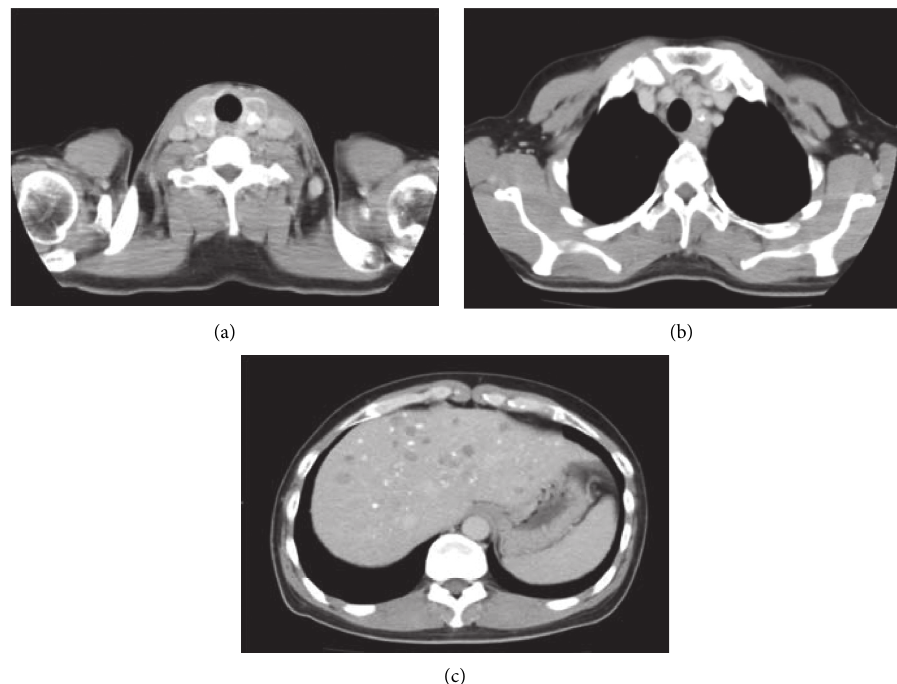
Figure 1: At the first visit to our hospital, computed tomography revealed a thyroid tumor (a), lymph node metastasis (b), and multiple cysts in the liver (c). The tumor was accompanied by